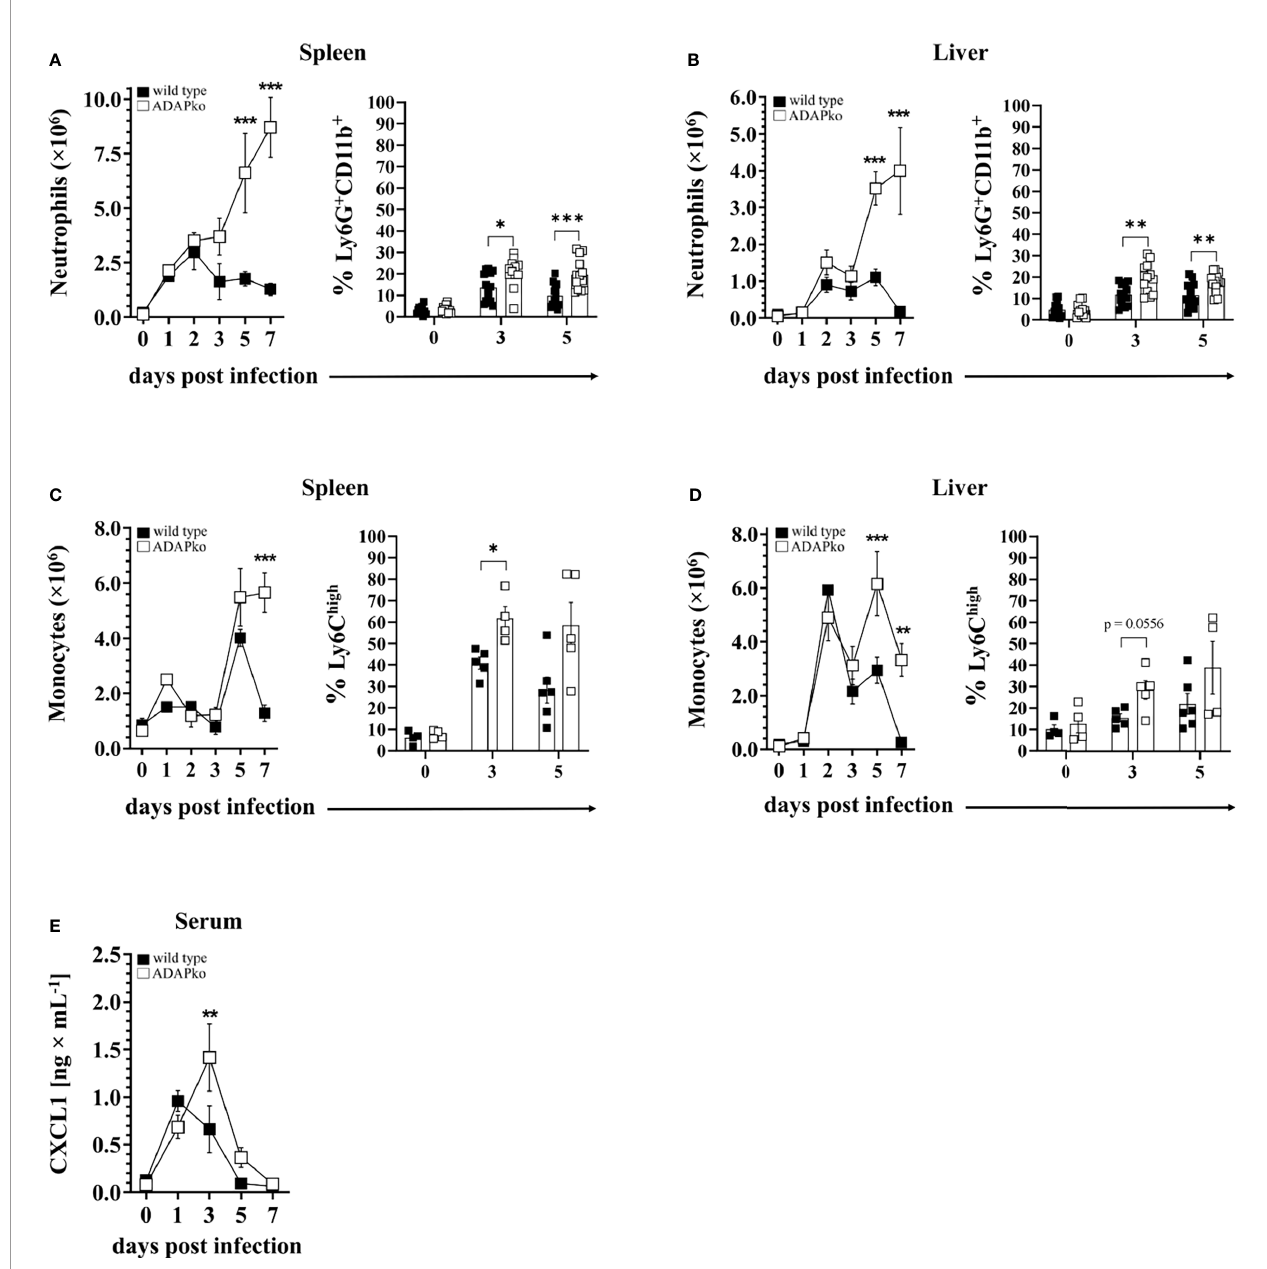
FIGURE 2 | Excessive in fi ltration of neutrophils and monocytes into the spleen and liver of Listeria monocytogenes (Lm)- infected ADAPko mice. Wild type ( ▪ ) and ADAPko ( ▫ ) mice (age: 10 – 17 weeks) were either infected i.v. with 2.5 × 10 4 CFU Lm (strain 10403S) or left untreated (uninfected control mice, day 0) and were sacri fi ced at the indicated times post infection. Leukocytes, gated as alive singlets and stained for CD45 + Lin − , were isolated from the spleen and liver and subsequently (A, B , left panel ) neutrophil (CD11b + Gr-1 + Ly6G + cells) and (C, D , left panel ) monocyte (CD11b + Gr-1 + Ly6G − cells) absolute numbers as well as the frequencies of (A, B , right panel ) neutrophils (CD11b + Ly6G + cells) and (C, D , right panel ) monocytes (CD11b + Ly6G − CX3CR1 low Ly6C high cells) were determined by fl ow cytometry. For all left panels, data are depicted as mean ± SEM for n = 4 – 5 individually analyzed mice, and statistical analyses were performed using two-way ANOVA with Bonferroni ’ s post-hoc test. Modi fi ed fi gure from (44). For all right panels, data shown are representative of three individual experiments (A, B) with n = 4 – 6 individually analyzed mice per group and one experiment (C, D) with n = 4 – 6 individually analyzed mice per group. (E) The concentrations of the neutrophil attracting chemokine CXCL1 was determined by cytometric bead array with n = 4 (uninfected control mice, day 0) and n = 8 – 9 (on the indicated times post infection) individually analyzed mice per group. Modi fi ed fi gure from (44). Data are depicted as mean ± SEM, and statistical analyses were performed using (A – D) unpaired, non-parametric Mann – Whitney test, and (E) analyses were performed using two-way ANOVA with Bonferroni ’ s post-hoc test (*p < 0.05, **p < 0.01, ***p < 0.001). ADAPko, adhesion and degranulation-promoting adaptor protein knockout; CFU, colony-forming